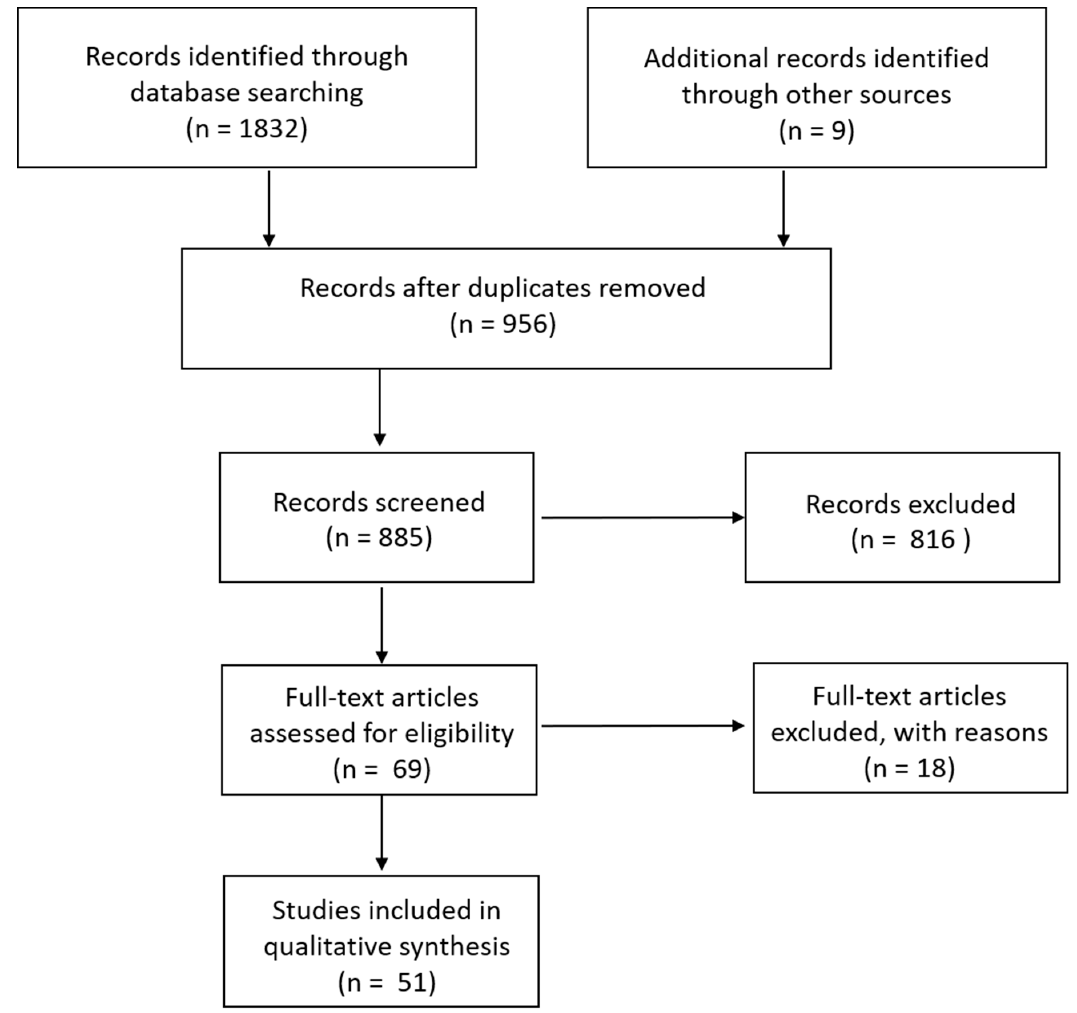
Figure 1. Schematic of search strategy.